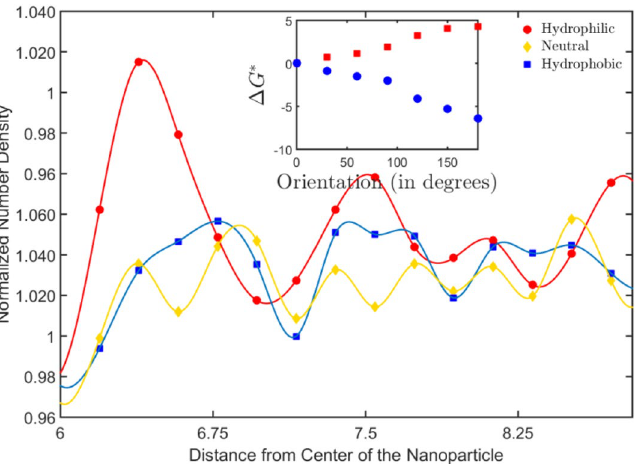
Figure 2. Number density variation of water molecule near particles having surfaces of different wettabilities. The water density crests and throughs alter the energy landscape around the particle, and in the process, favor particular orientation as also observed with the free energy calculations for reorientation, as shown in the